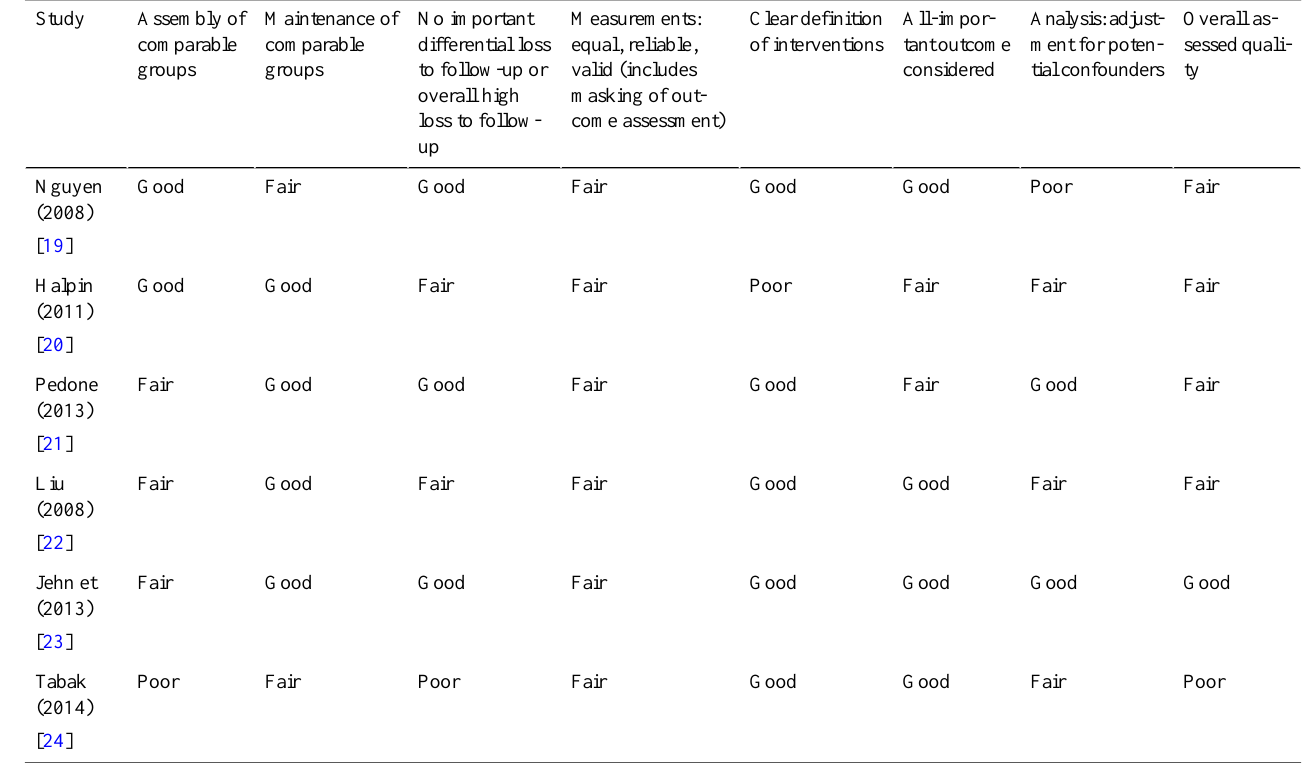
Table 4. Assessment of potential bias of studies selected for inclusion using USPSTF Quality Rating Criteria [16].